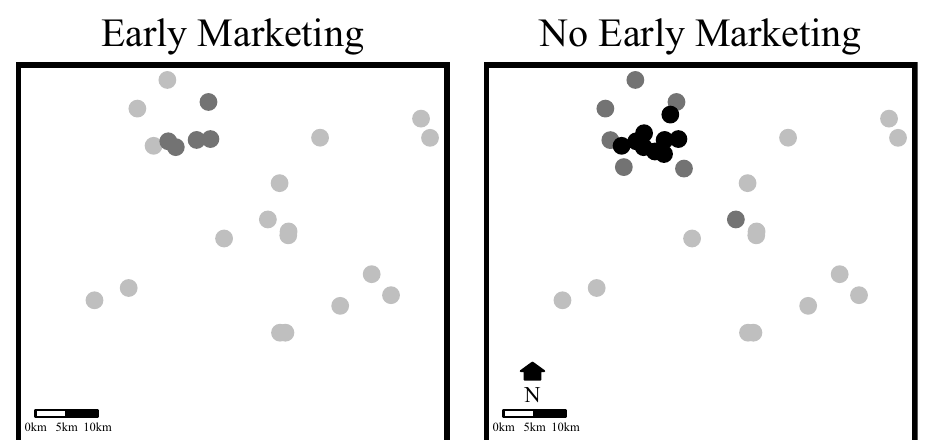
Fig 6. Controlled marketing risk map. Risk maps considering the number of susceptible premises on April 14 th , 2015 in a county in Minnesota that sent houses early to processing prior to the regular market date as an outbreak response measure. The plot to the left was estimated considering the susceptible premises with early marketing having been performed, while the plot to the right was estimated assuming houses had been marketed regularly. Light gray points are low risk premises ( R 0 < 0.7 ), dark gray points are moderate risk premises ( 0.7 (cid:20) R 0 (cid:20) 1.0 ), and black points are high risk premises ( 1.0 < R 0